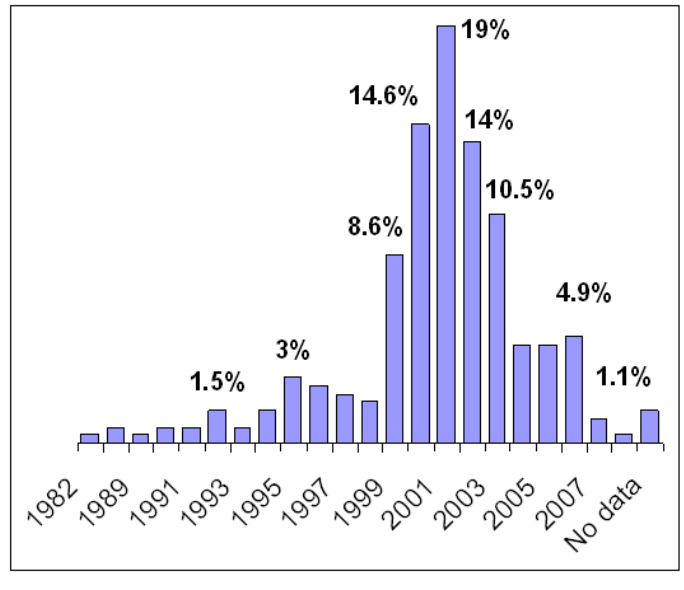
Figure 1. SCS Activation